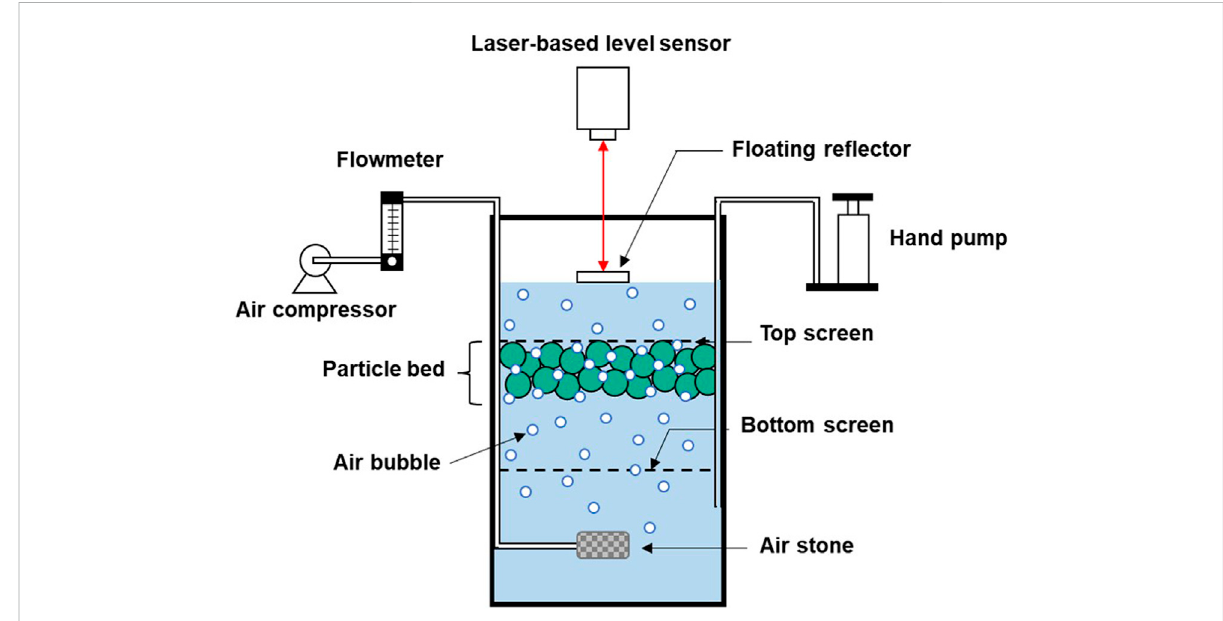
FIGURE 2 A schematic diagram of the laser-assisted measurement setup for the determination of attached-bubble